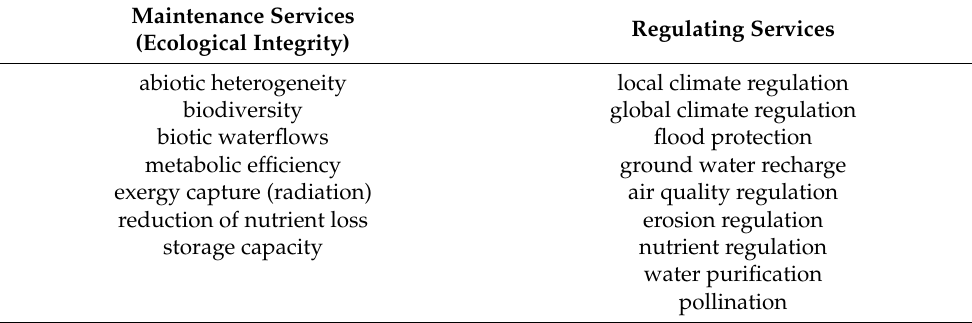
Table 1. Overview of indicators and services summarized as capacity of ecosystems to supply regulating and maintenance ES. See source studies of Burkhard et al. [63,65] for more detailed explanation of the services and Müller [66] for derivation of indicators of ecological integrity.